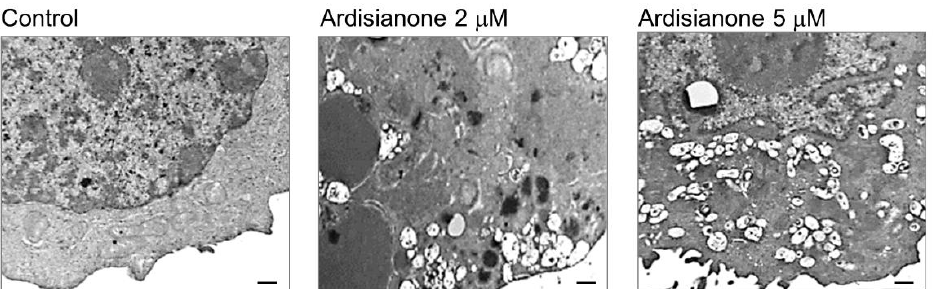
Figure 5. Transmission electron microscope examination of ardisianone-treated HL cells. The cells were treated with or without ardisianone (2 µ M) for 24 h. The cells were harvested, washed, and fixed as described in the Materials and Methods section. The cells were dehydrated using alcohol and embedded in epoxy resin for sectioning. Ultrathin sections were stained with uranyl acetate and lead citrate and then examined with a Hitachi H-7500 transmission electron microscope. Scale bar, 500 nm.